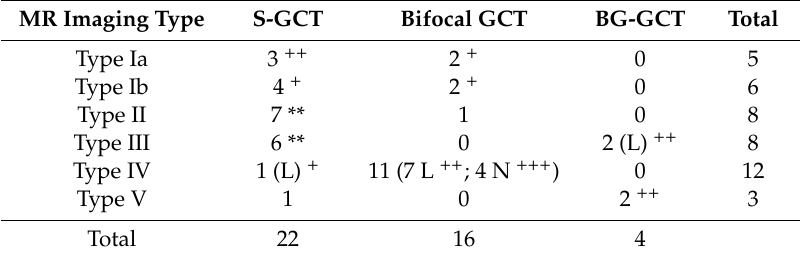
Table 1. Magnetic resonance imaging types.